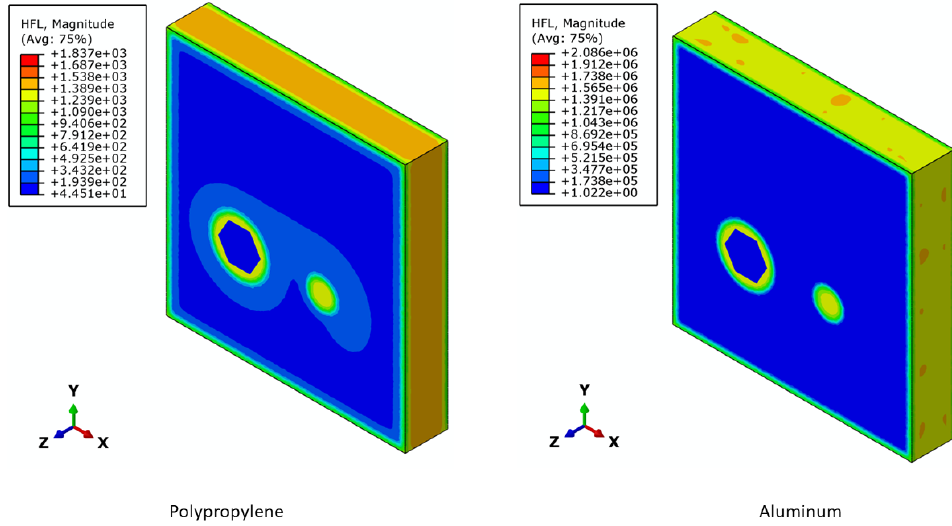
Figure 7. Heat flux in the Z-direction of the camlock model with different materials. Table 2. Orthotropic thermal conductivities derived from the camlock model.